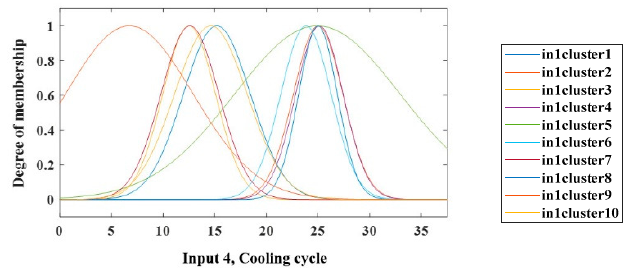
Figure 8. Optimized membership functions for the cooling cycle.